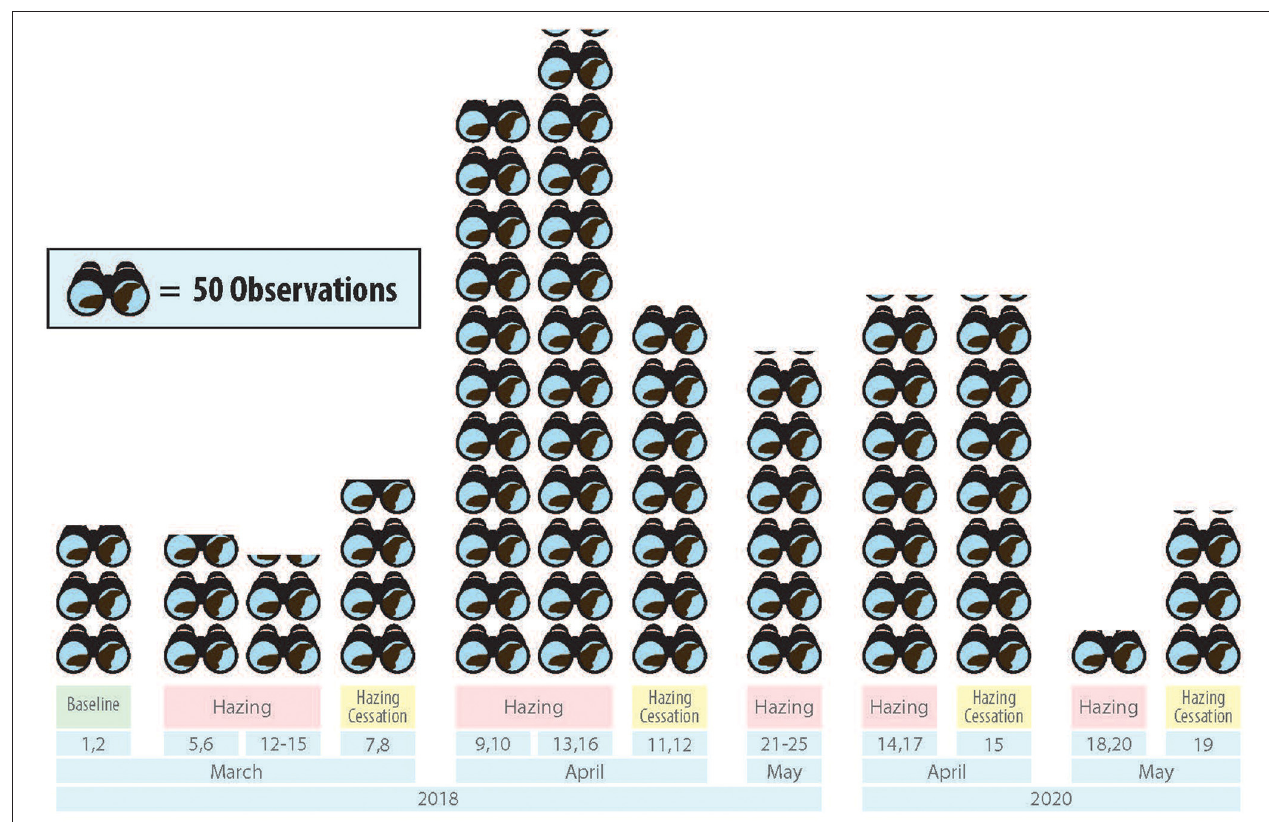
FIGURE 3 | Treatment and sampling chronology for the study of Steller Sea Lion response to hazing at Bonneville Dam. Observations are the unique number of times surface active animals were recorded for study purposes during defined observation periods.